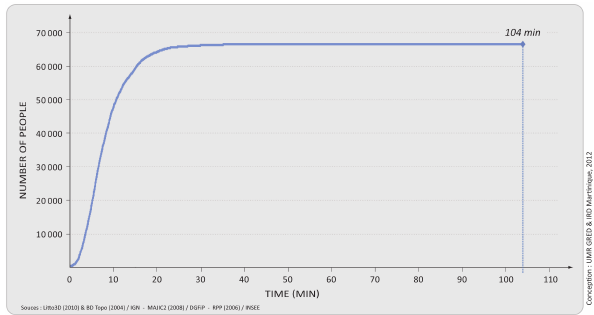
Fig. 3. Accessibility curve of safe zones for the whole Martinique (night population located under 10ma.s.l., 20m high shelter sce- nario).